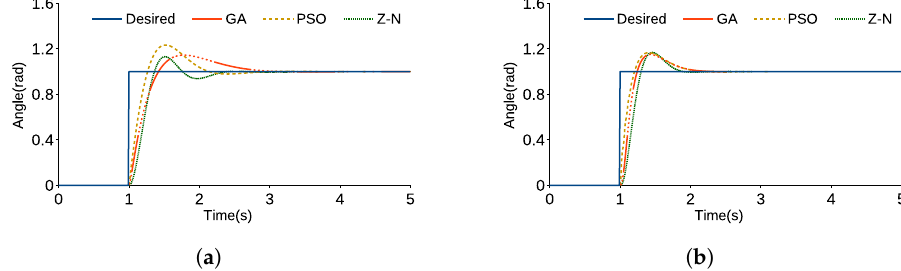
Figure 6. Step response for closed-loop controller system. ( a ) Hip; and ( b )